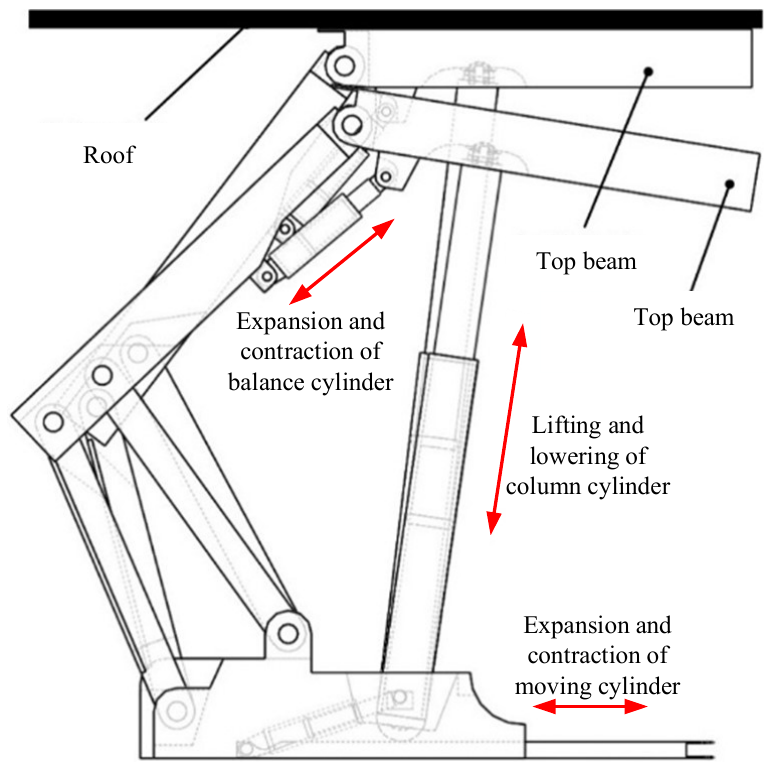
Figure 9. Schematic diagram of sample collection experiment of hydraulic support. The sample collection experiment of column cylinder is shown in Figure 10.